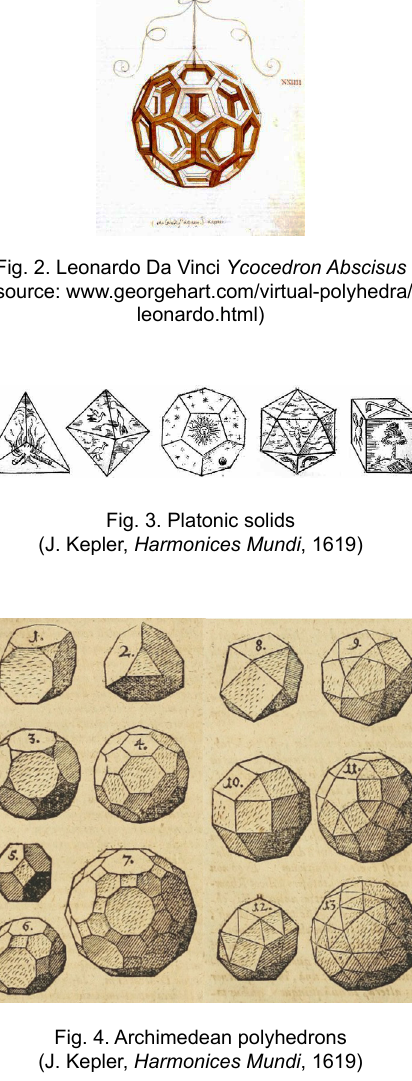
Fig. 4. Archimedean polyhedrons (J. Kepler, Harmonices Mundi ,